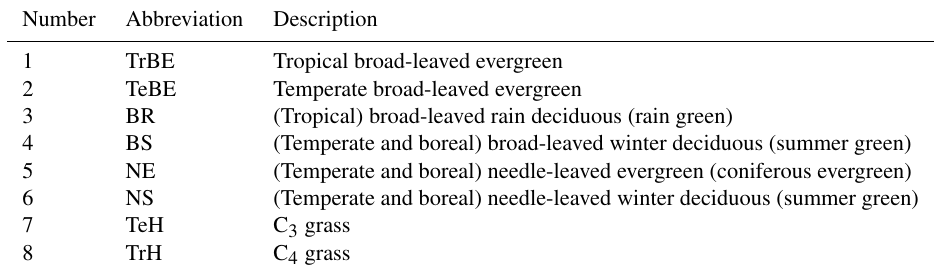
Table 1. Description of plant functional types used in the